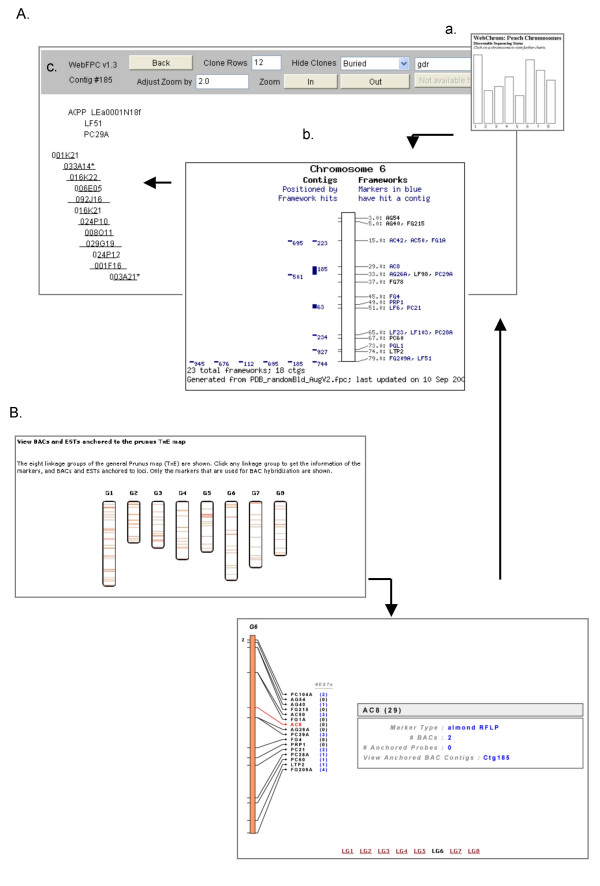
Graphical interface to maps. A. Peach WebChrom and peach WebFPC: a. the opening page of peach WebChrom with eight linkage group of the general prunus map; b. an example of individual linkage group pages (linkage group 6) with the associated markers and the contigs; c. an example of the directly linked FPC page with the developing BAC contigs and anchored probes (contig #185). B. Map Viewer: Map viewer displays the general Prunus map with anchored ESTs and direct link to WebFPC.